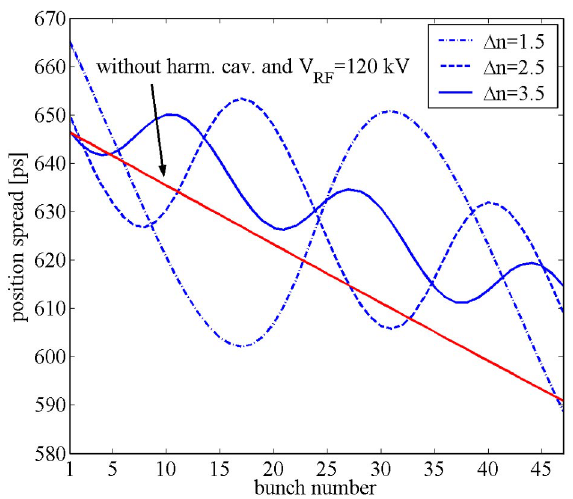
(cid:4) 1 : 6 A into b